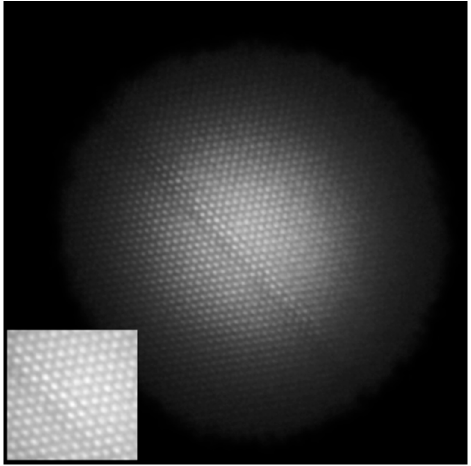
Figure 4. HRTEM image in [110] zone axis focused at the GaAs/Znse interface. In the inset a magnified view of the HRTEM image contrast at the interface.